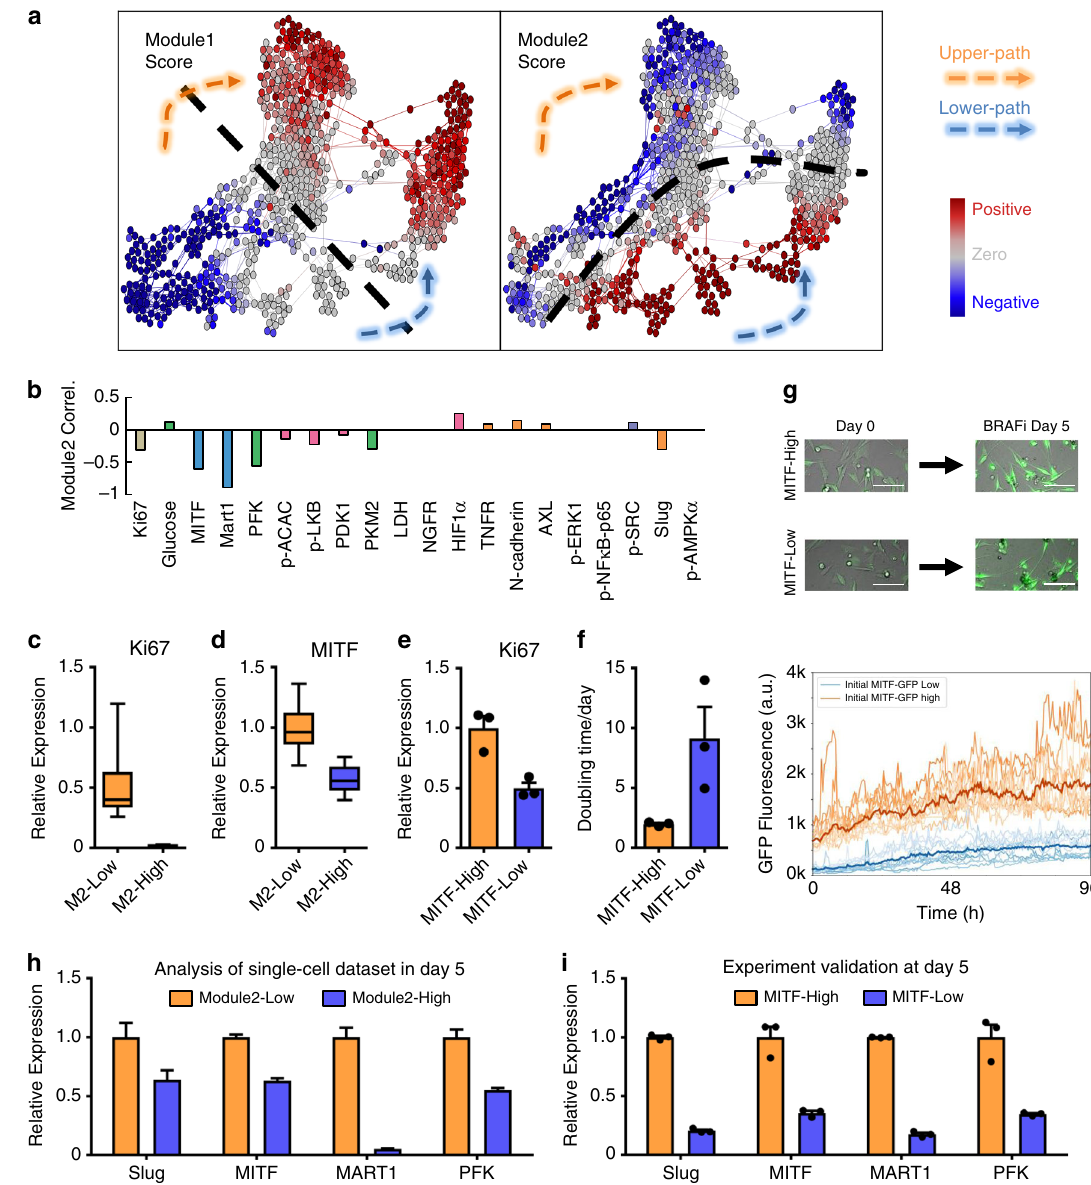
Fig. 3 Surprisal analysis identi fi es MITF as a transcription factor regulating the bifurcation. a Visualization of the in fl uence score of the two regulatory modules identi fi ed from surprisal analysis. Module 1 is time-dependent, whereas module 2 exhibits a path-speci fi c pattern. The dashed black lines indicate the region for which the respective module scores of each cell approach zero. b Pearson ’ s correlation between individual marker levels and the module 2 score. c , d Boxplot of Ki67 and MITF expression level in module 2 score-high and -low subpopulations at day 0. Data are median with fi rst and third quartiles (box), and top and bottom quartiles (whiskers) indicated. Each experiment is the result of n = 16 biologically independent cells per group. e Ki67 relative expression, measured by qPCR in sorted MITF-High and MITF-Low cells at day 0. Each experiment is the result of n = 3 biologically independent samples per group. f Doubling time measured in treatment-naive condition, collected from sorted MITF-High and MITF-Low cells at day 0. Each experiment is the result of n = 3 biologically independent samples per group. g Single-cell time-lapsed microscopy analysis of MITF-activity during 5 days of BRAFi. Top panel: time-lapse images of sorted GFP-High and GFP-Low cells before and after 5 days of BRAFi. Representative images from three biological replicates are shown. Scale bar, 100 µ m. Bottom panel: single-cell MITF-reporter traces for MITF-High (orange) and MITF-Low (blue) cells. Bold lines represent the mean response. h Slug, MITF, MART1, and PFK relative expression levels in module 2 score-high and -low subpopulations, collected from cells at day 5 and analyzed from the single-cell dataset. Each experiment is the result of n = 16 biologically independent samples per group. i Slug, MITF, Mart1, and PFK expression, measured by qPCR in sorted MITF-High and MITF-Low day-0 cells that have been treated with BRAFi for 5 days. Each experiment is the result of n = 3 biologically independent samples per group. Data are presented as mean values±SEM. Source data are provided as a Source Data fi To further con fi rm that the sorted cells reach their respective differentially expressed between the two paths (negative- and destination states after 5 days of drugging, we quanti fi ed the positive-valued module 2) at D5 (Fig. 3h and Supplementary markers that are differentially expressed between the upper and Figs. 13 and 20a). By analyzing the expression of these four genes lower paths at D5. Mining of the single-cell data sets revealed that in sorted MITF-High and MITF-Low D0 cells after 5 days of several markers, including Slug, MITF, MART1, and PFK, are treatment (Supplementary Fig. 20b), we found that their